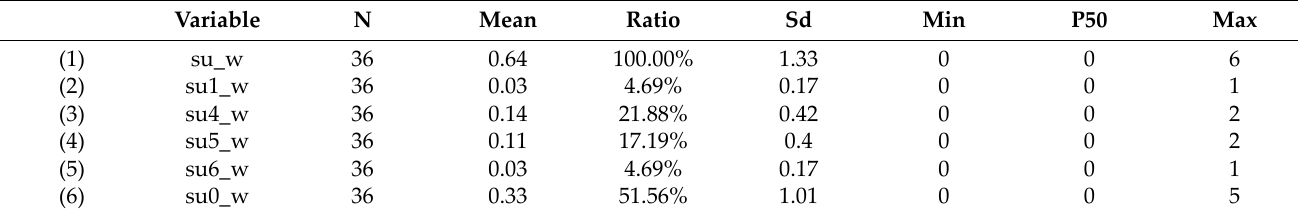
Table 6. Results of the analysis of the level‑2 supplier subdimension on social